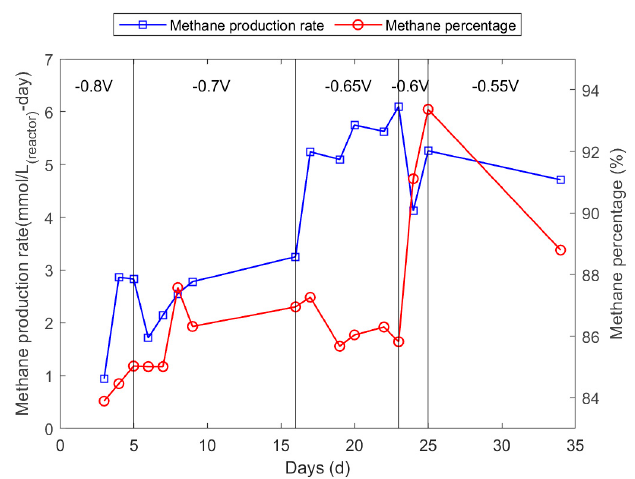
Figure 2. Methane production and methane percentage at different cathode potentials.